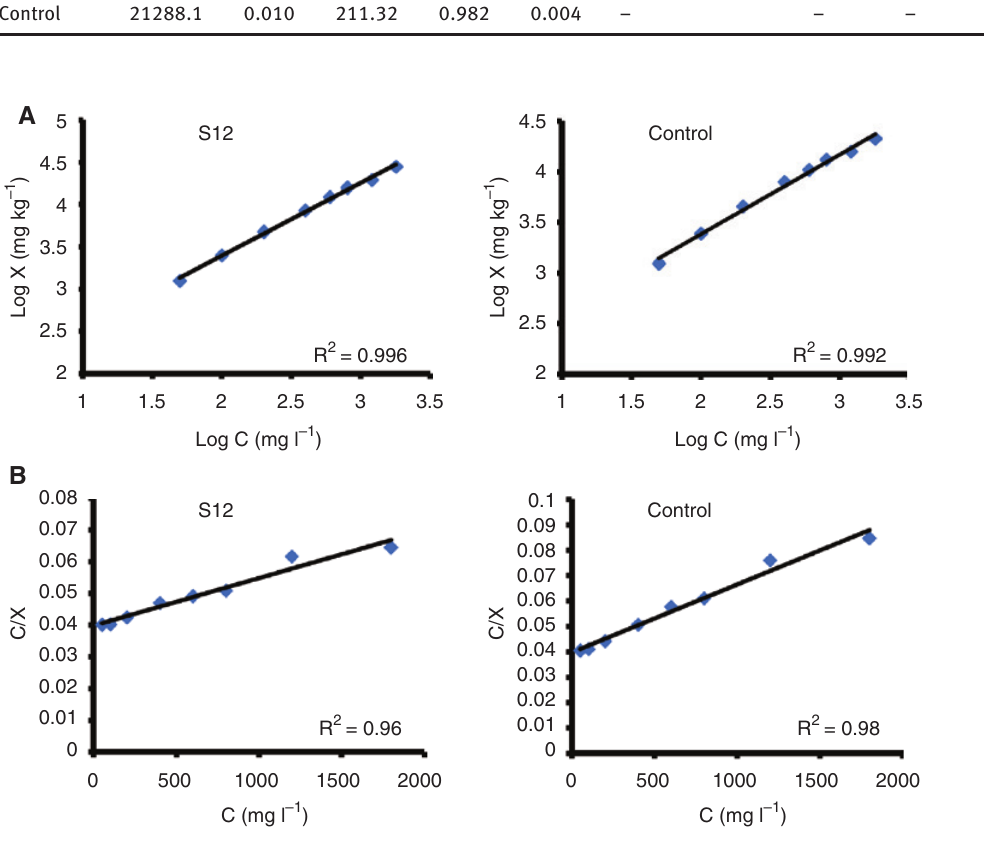
Figure 2: Cd sorption isotherm data for treated soil (S12) and control soil (A) fit of the linear form of Freundlich equation, (B) fit of the linear form of the Langmuir equation.